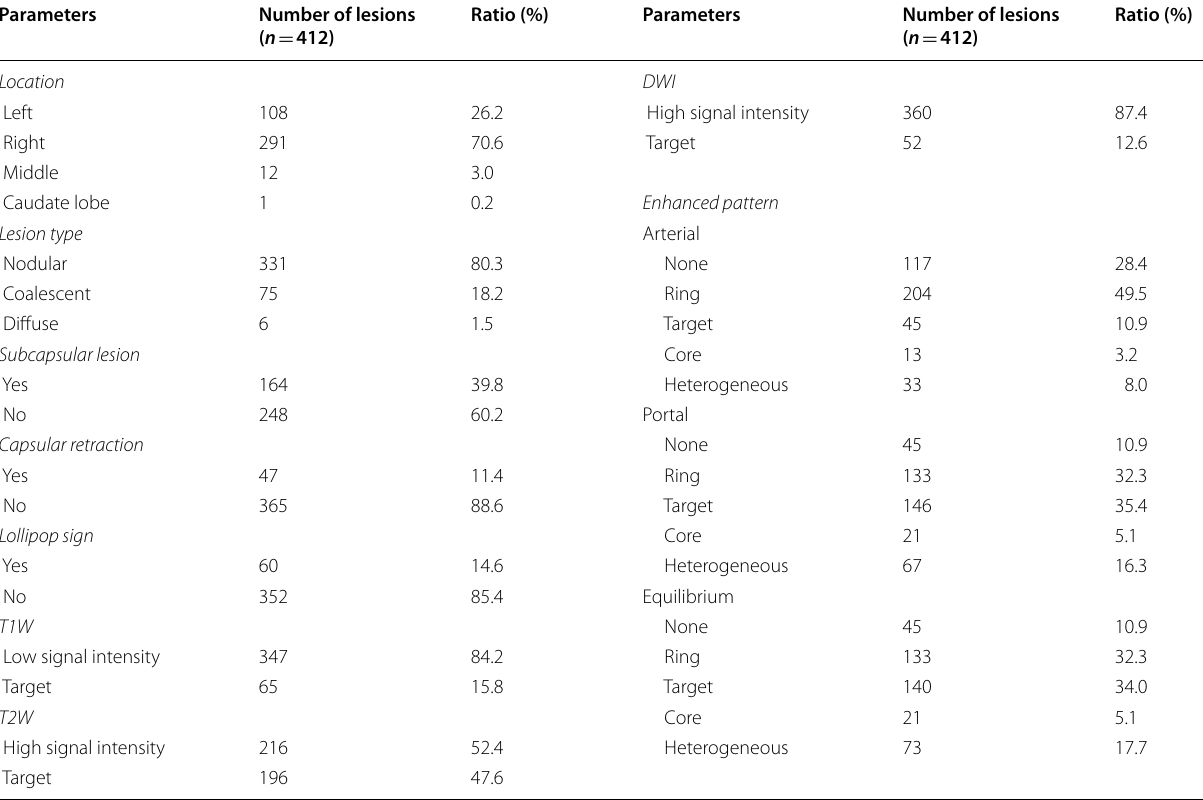
Table 1 MRI characteristics of all evaluated intrahepatic lesions of HEH patients